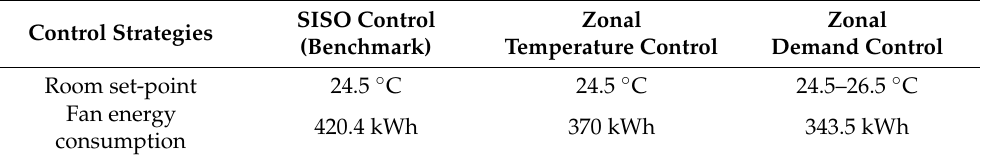
Table 2. Fan energy consumption with three control